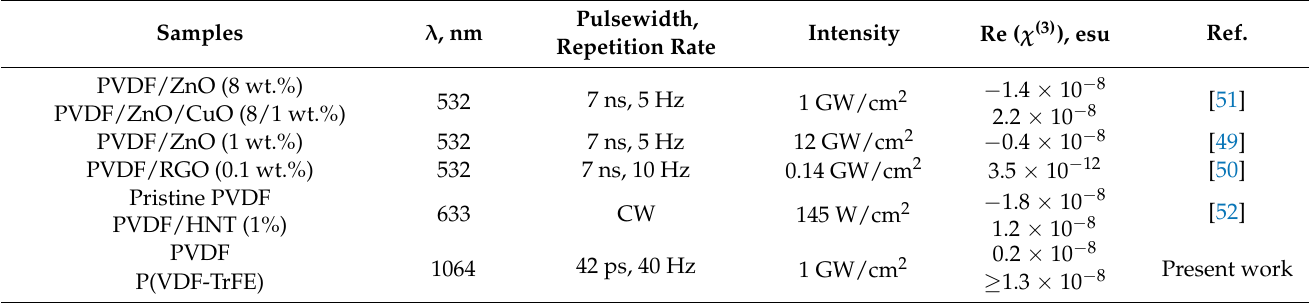
fect manifestation at wavelength 1064 nm corresponded to the reference data, where the sign and the magnitude of Re( χ (3) ) depended on dopant type and its concentration. The